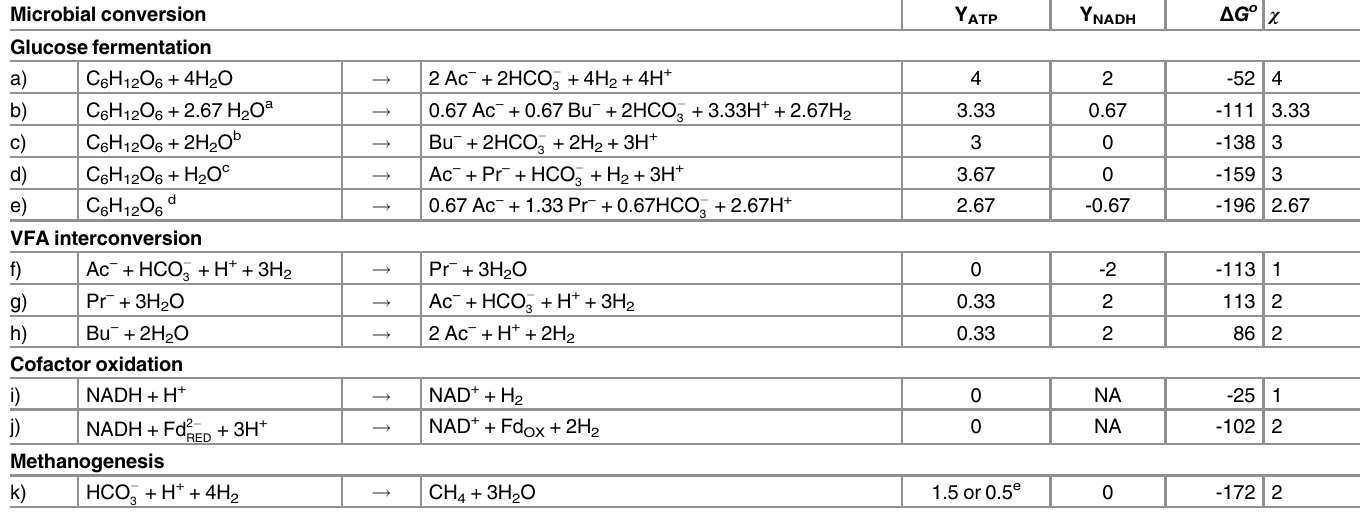
a Butyrate production via the kinase route b Either for butyrate production via the kinase route or a linear combination of reaction a) and 2Ac − + 2C butyrate production via the CoA-transferase route c Propionate production via succinate